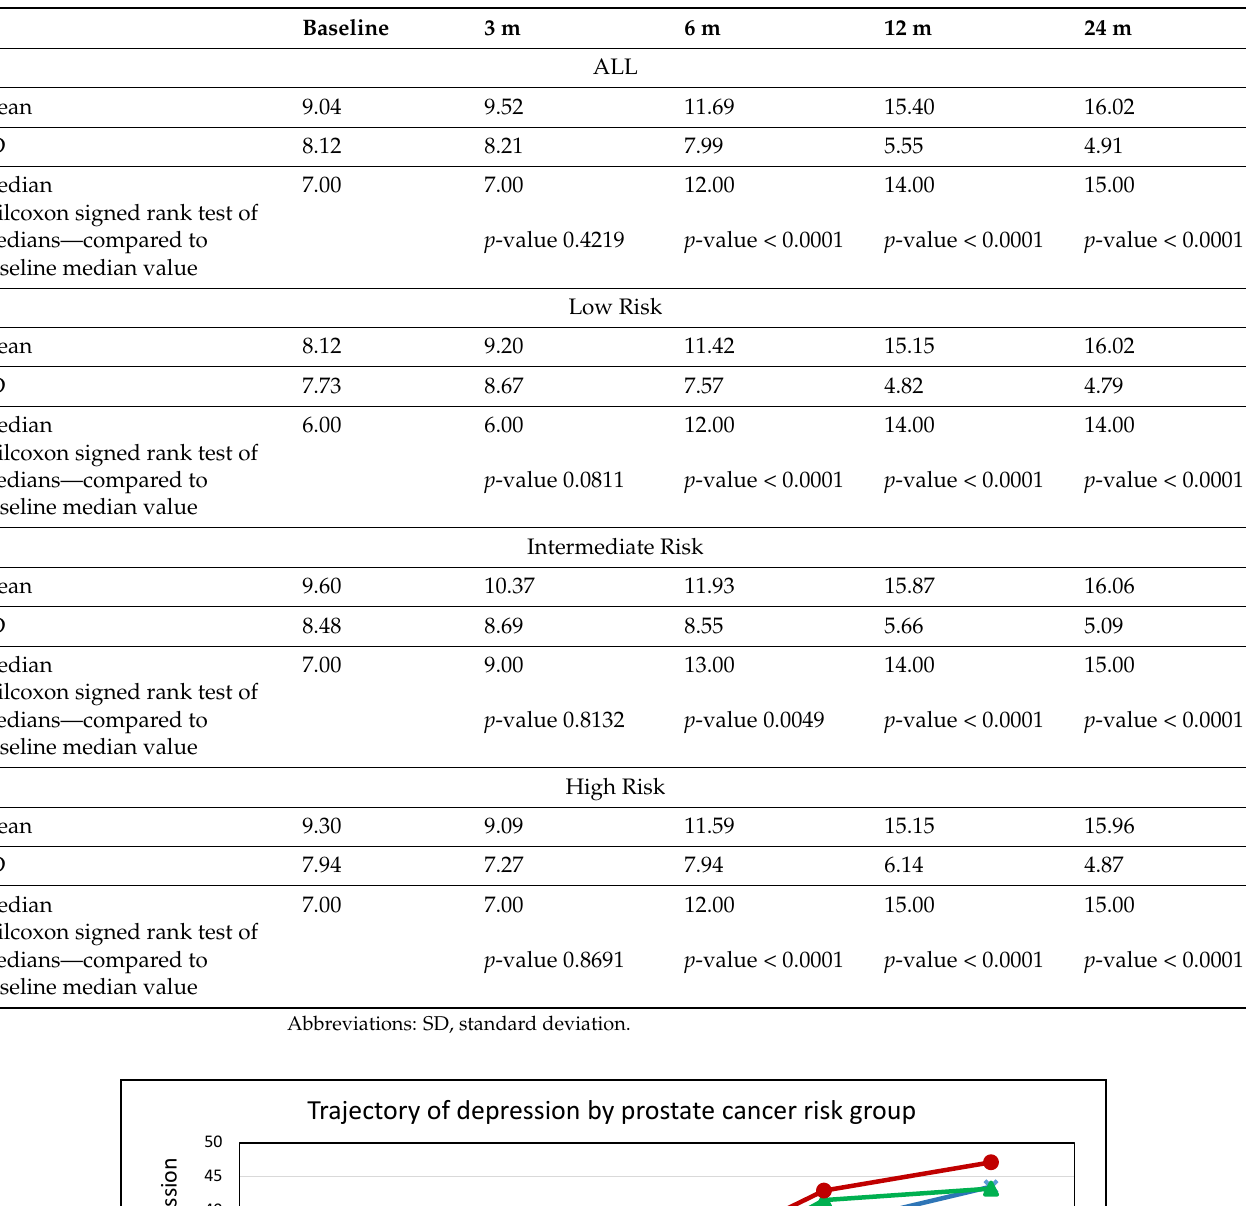
Table 2. Distribution of CES-D scores over time, and by prostate cancer risk group.